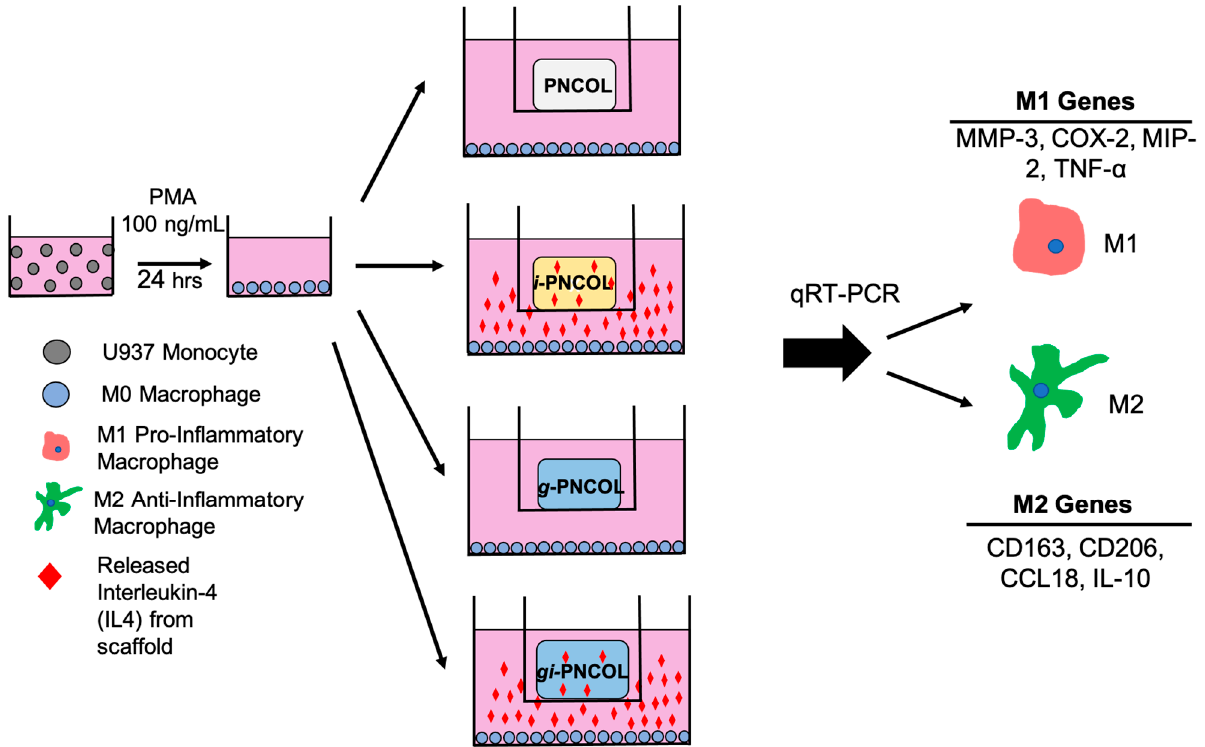
Figure 11. Study design for macrophage polarization upon IL-4 release from the genipin crosslinked and uncrosslinked scaffold.